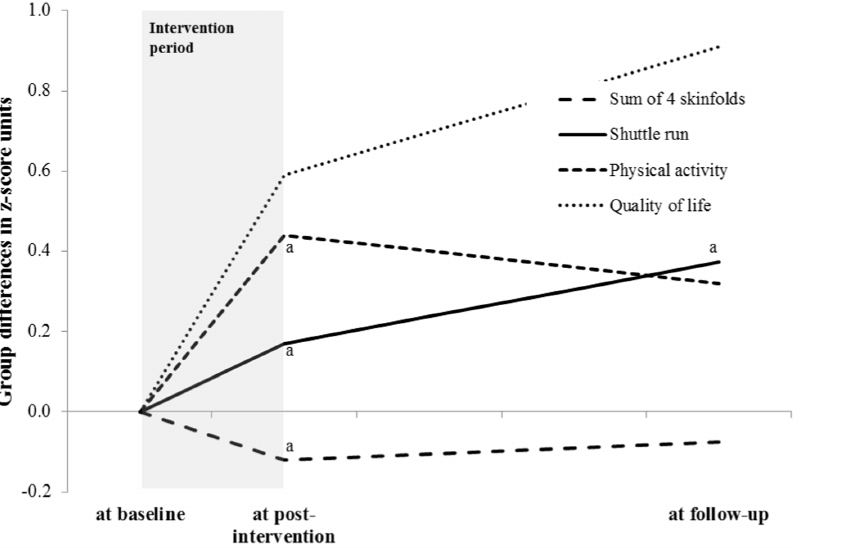
Figure 2. Schematic illustration of the differences for the four primary outcomes between the intervention and the control group at baseline, after nine months physical activity intervention, and three years after cessation of the intervention. Post-intervention results derive from previously published results with different sample sizes [14] (for body fat (n=485 at post-intervention/n=293 at follow-up); fitness (n=472/n=281); physical activity (n=303/n=145); quality of life (n=427/n=191)). a significantly different values in favour of the intervention group compared to the control group. doi:10.1371/journal.pone.0087929.g002 PLOS ONE |